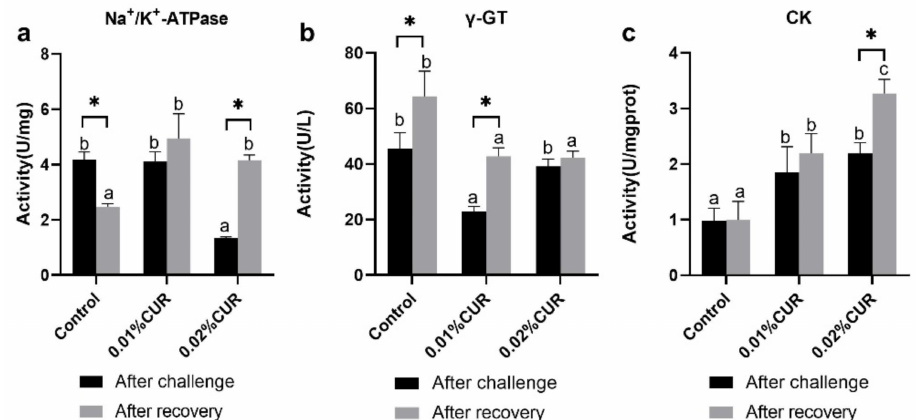
Figure 2. ( a ) Na + K + adenosinetriphosphatase (Na + K + –ATPase), ( b ) γ -Glutamyl transferase ( γ -GT), ( c ) creatine kinase (CK) activities of greater amberjack fed with dietary curcumin supplementation. (Different letters above bars and asterisk sign (*) indicate significant differences at the 0.05 level).